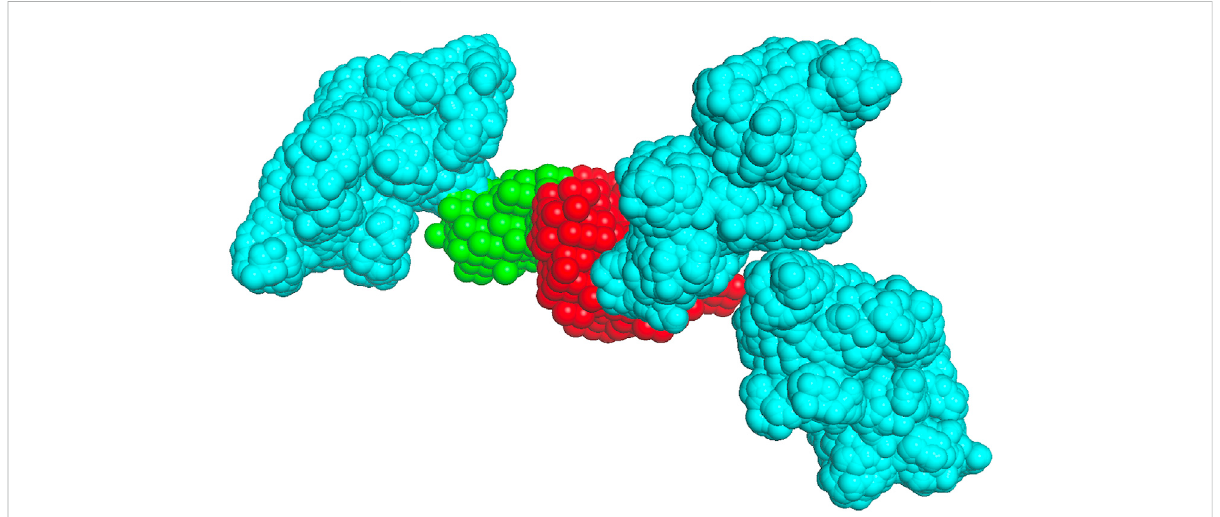
FIGURE 3 Crowder packing. The receptor (1s78 chain A) is in red, the native pose of the ligand (1s78 chains CD) is in green, and the albumin crowders at a 0.06 volume fraction (shown for clarity only within 50 Å of the receptor surface) are in cyan.